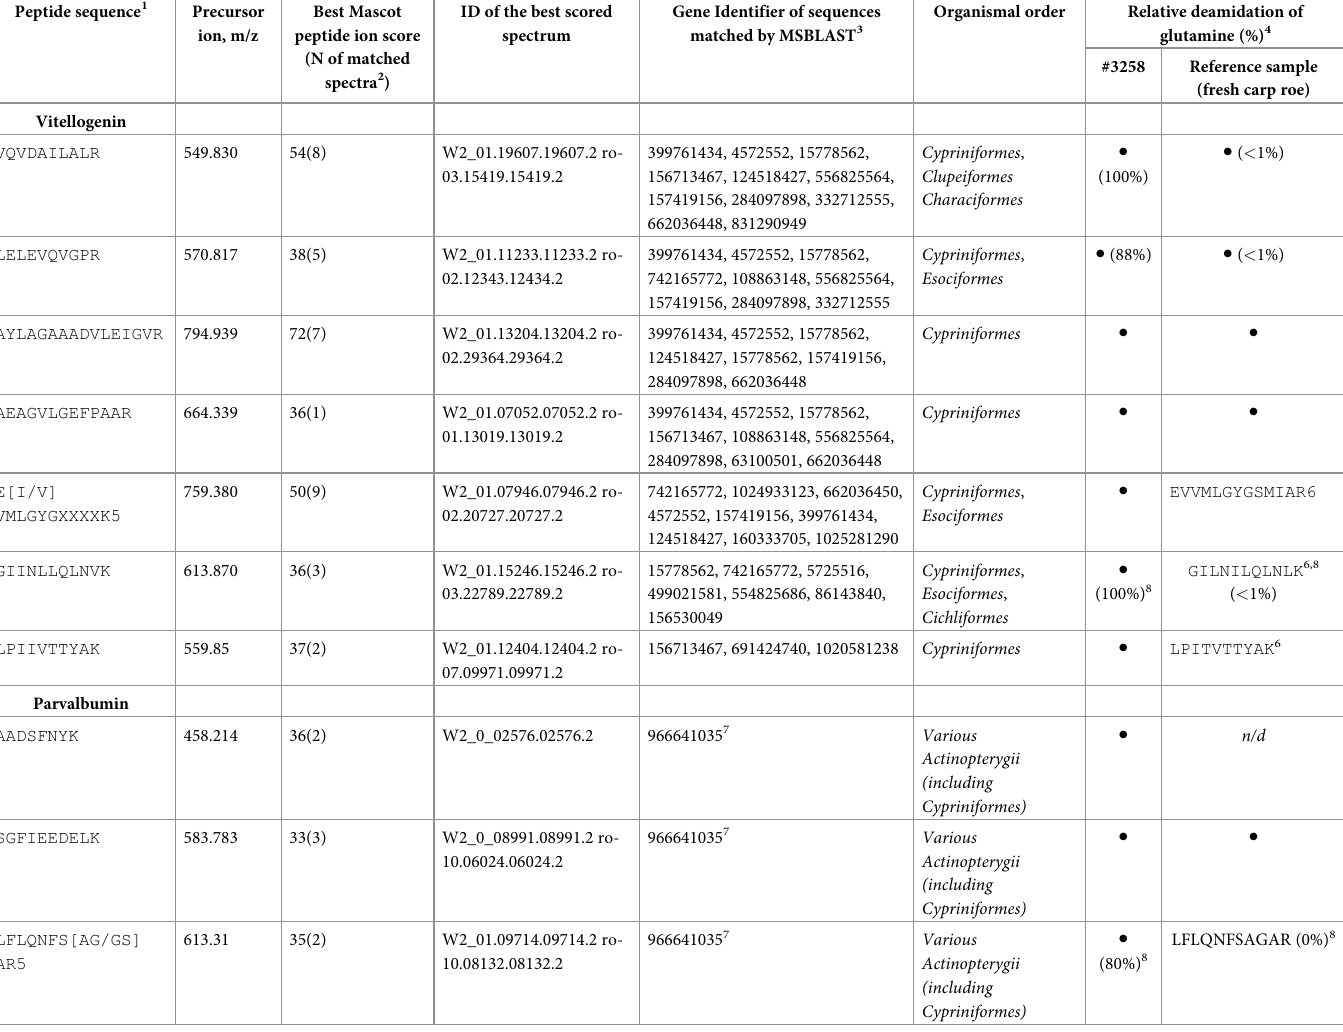
Table 4. List of peptides matched to fish vitellogenin and parvalbumin in foodcrust #3258 �